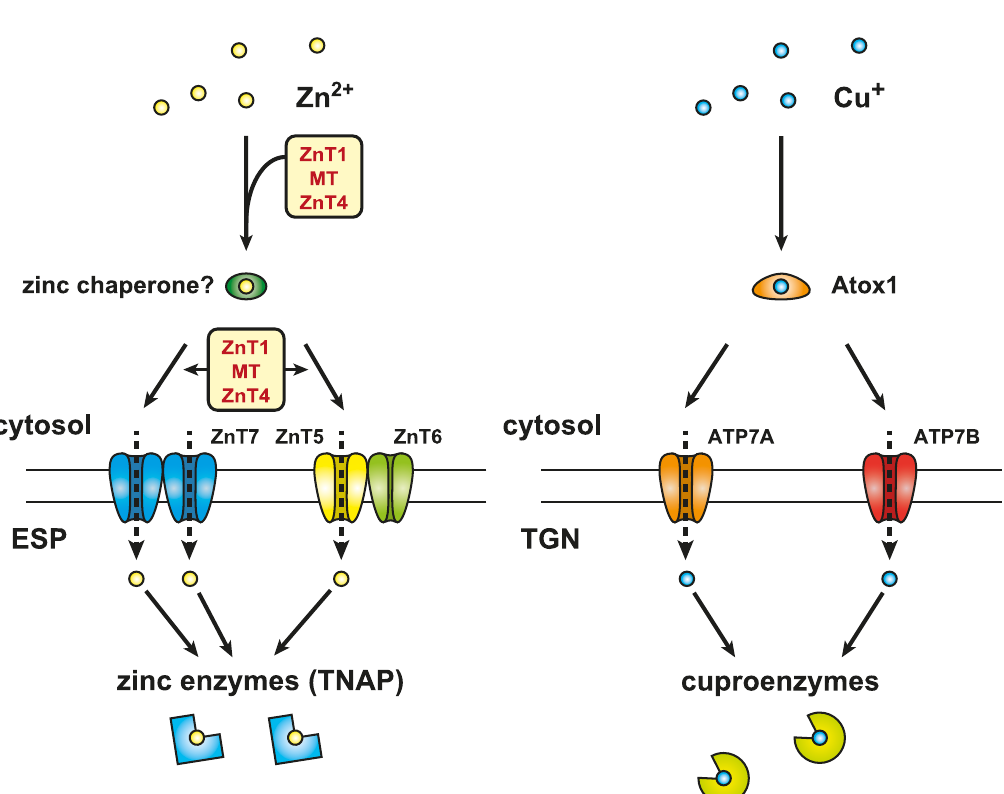
Figure 5. Cooperative function of MT, ZnT1, and ZnT4 in the activation of zinc-requiring ectoenzymes. The facilitated transfer of cytosolic zinc to ZnT5–ZnT6 heterodimers and ZnT7 homodimers may function under cooperative control of ZnT1, MT, and ZnT4 ( left ). ZnT1MTZnT4 KO cells exhibit significantly reduced TNAP activity ( left ), which is reminiscent of the phenotypes of cytosolic copper chaperone Atox1 -deficient cells ( right ). Atox1 plays a crucial role as a copper chaperone in transferring cytosolic copper to two copper-transporting P-type ATPases, ATP7A and ATP7B, located in the trans -Golgi network (TGN). This therefore contributes to the activation of copper-requiring ectoenzymes (cuproenzymes). Considering the high level of analogy between ZnT1MTZnT4 KO and Atox1 -deficient cells, a putative zinc chaperone under the cooperative control of ZnT1, MT, and ZnT4 is hypothesized to play a crucial role in facilitating the transfer of cytosolic zinc to ZnT5–ZnT6 heterodimers and ZnT7 homodimers (not shown) located in the early secretory pathway (ESP). This then contributes to the proper activation of zinc-requiring ectoenzymes such as TNAP ( left ).